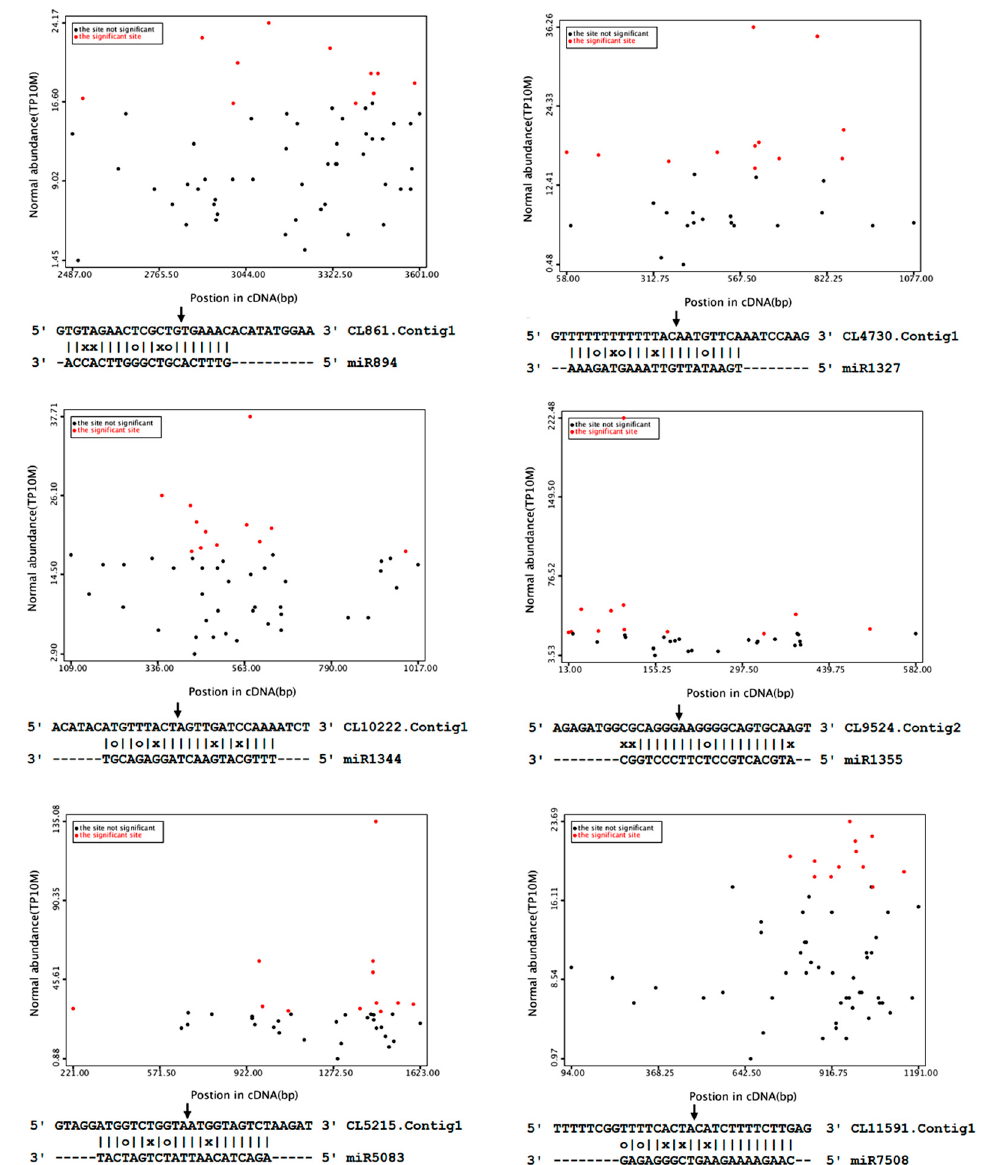
Figure 6. Target plot (t-plot) for target genes of less-conserved miRNAs. Arrows indicate the signatures corresponding to the miRNA cleavage site. Partial mRNA sequences of target genes aligned with the miRNAs show perfect matches (straight lines), G-U wobbles (circles).